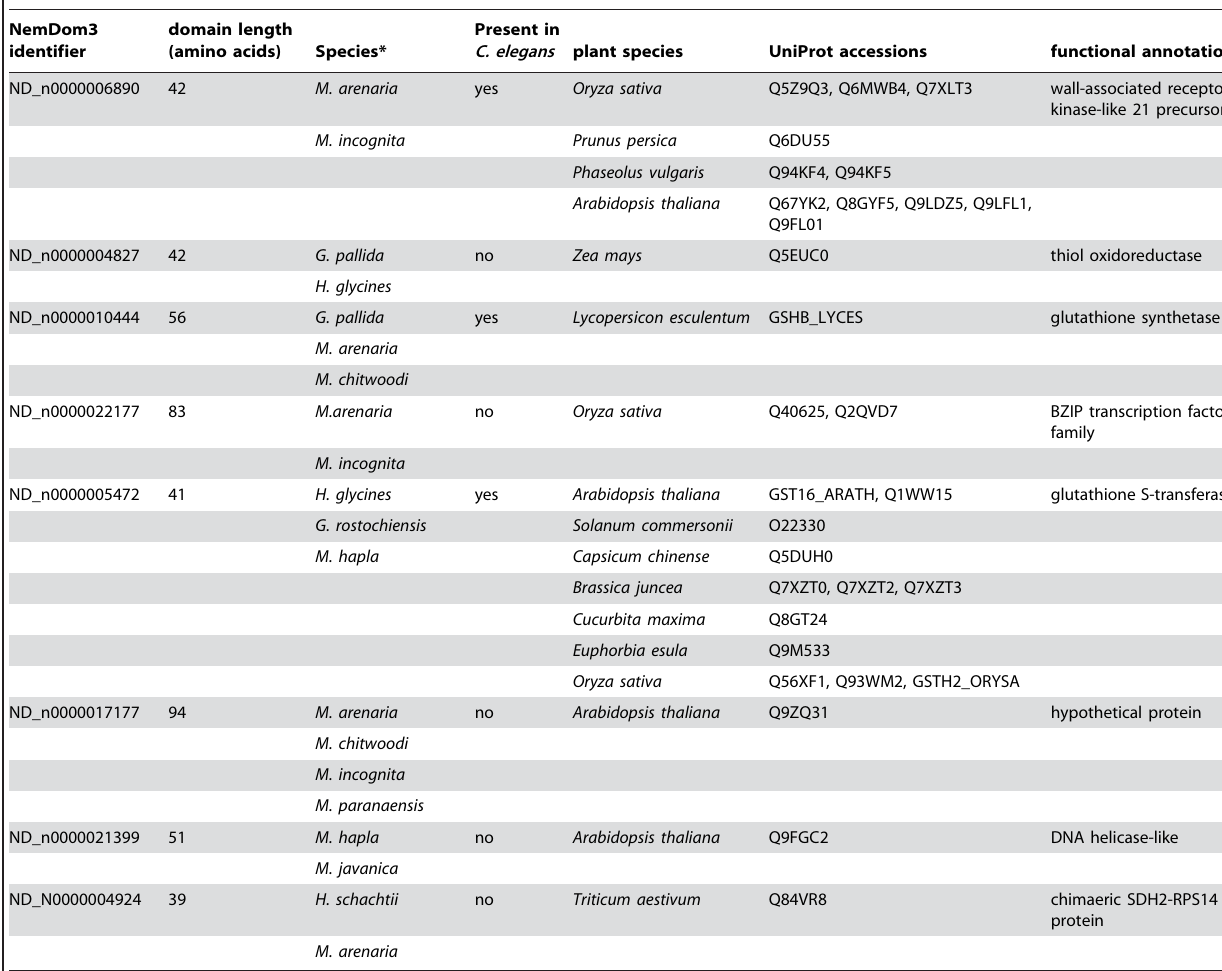
Table 3. Novel NemDom3 domains also identified in plants